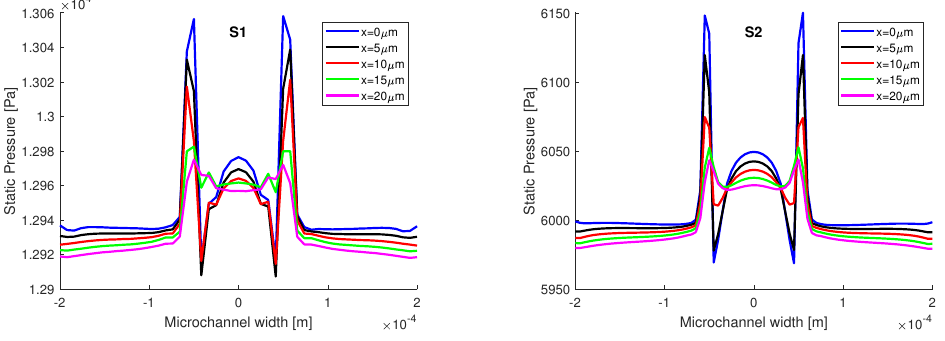
Figure 10. Distributions of static pressure on 5 lines in the middle plane at h = 25 µ m.